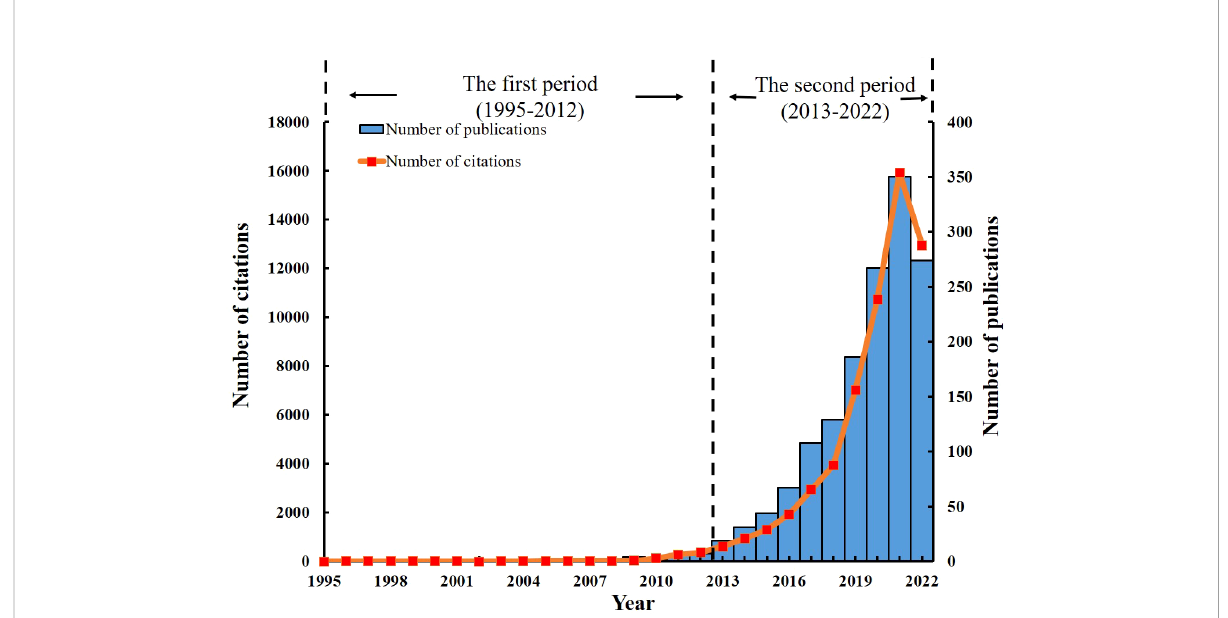
FIGURE 2 The number of annual publications and citations of articles concerning the GM in CVD from 2004 to